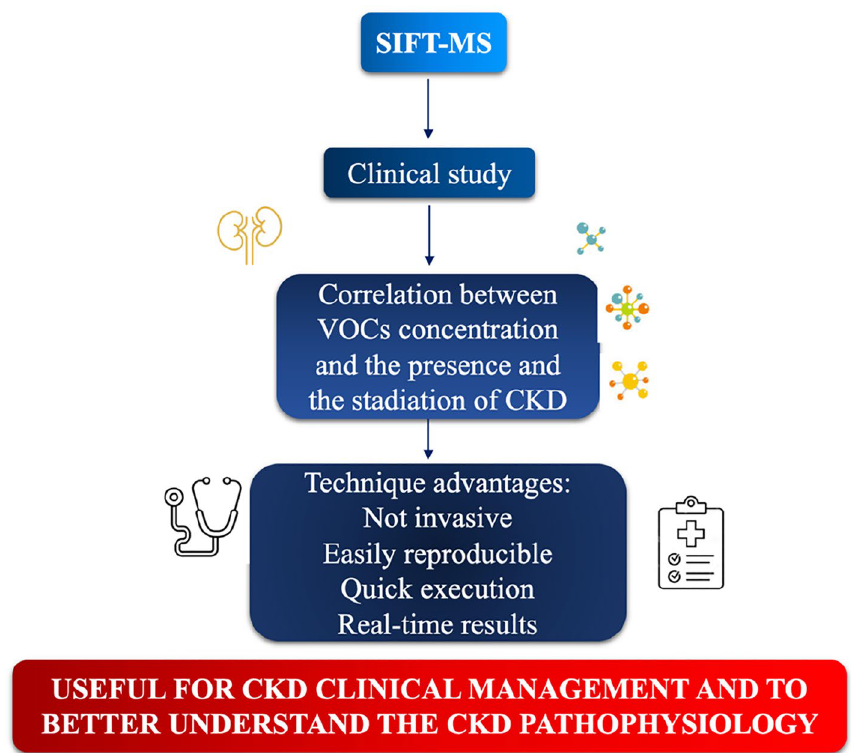
Figure 2. Utility of SIFT-MS in the evaluation of VOCS in the exhaled air of CKD patients. Abbreviations: CKD chronic kidney disease; SIFT-MS selected ion flow tube-mass spectrometry; VOCs volatile organic